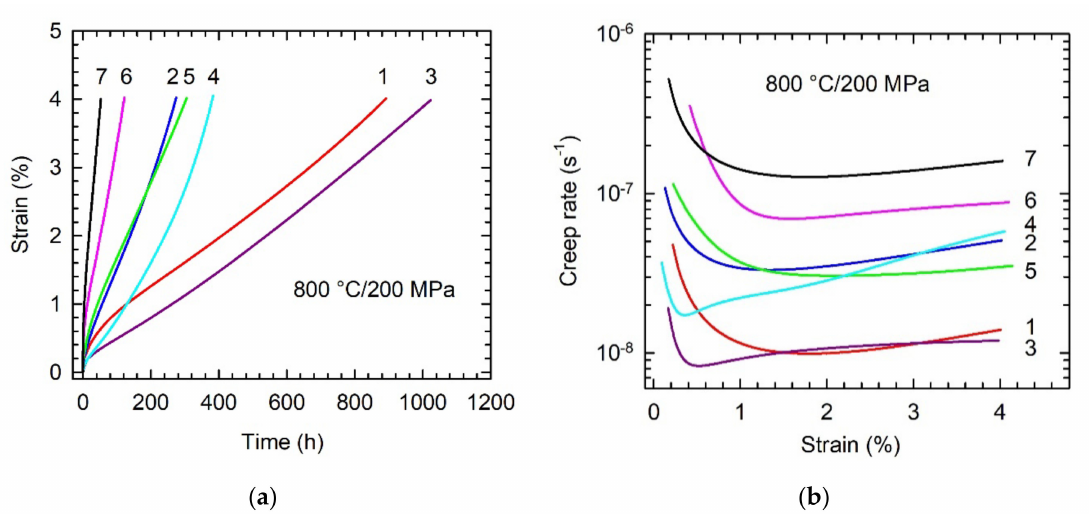
Figure 11. Creep deformation curves at a temperature of 800 ◦ C and applied stress of 200 MPa: ( a ) Dependence of creep strain on time; ( b ) Dependence of creep rate on strain. Designation and composition of reference alloys (in at.%): 1—studied C20 alloy, 2—studied C36 alloy, 3—Ti-46.4Al-5.1Nb-1C-0.2B, 4—Ti-46Al-8Ta, 5—Ti-45Al-2W-0.6Si-0.7B, 6—Ti-46Al-2W-0.5Si